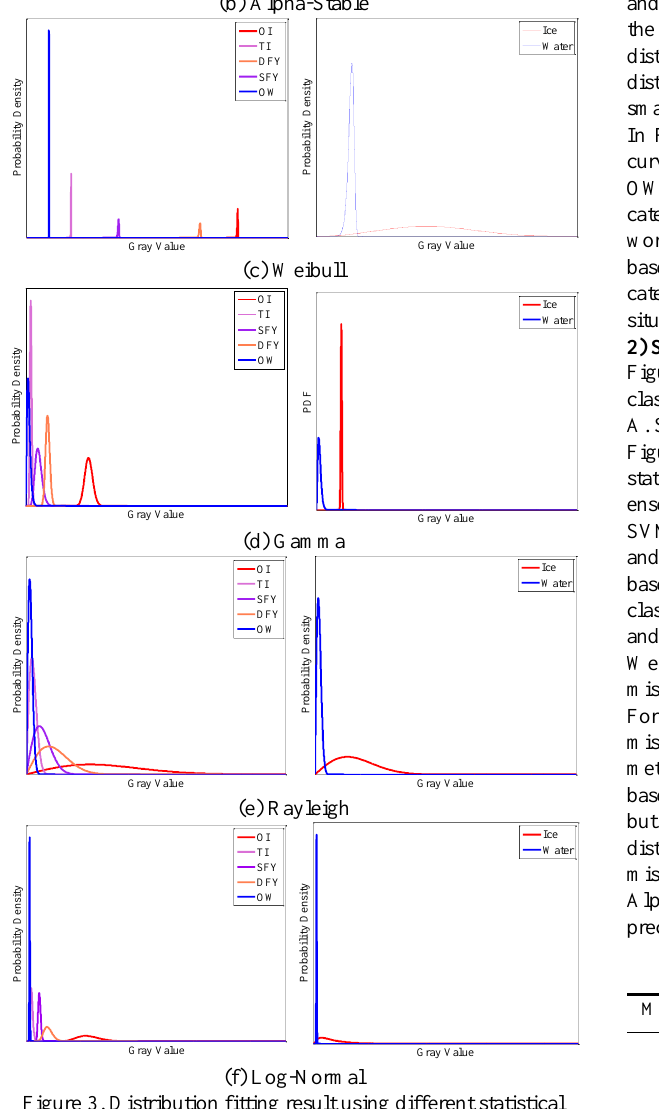
Figure 3. Distribution fitting result using different statistical distribution